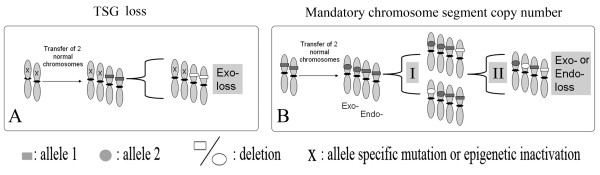
Chromosomal changes, expected on the basis of the "TSG loss" and the "mandatory chromosomal segment copy number" models, respectively. A. The putative TSG is inactivated in the recipient tumor cell. Following the transfer of normal chromosomes, only the loss of exogenous TSG copies would provide the cell with selective growth advantage. B. The recipient tumor cell must maintain equilibrium with regard to the total copy number of certain chromosomal segments. Transfer of supernumerary chromosomes is followed by the restoration of the original balance by a multi-phase expansion of clones, losing first one, then the other extra-copy of the critical regions, irrespectively of their endo- and exogenous origin.